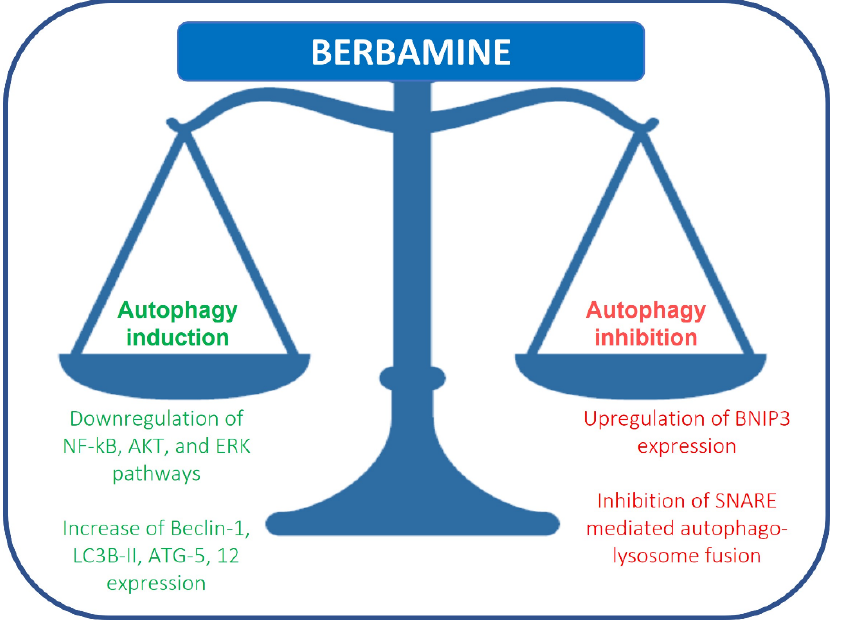
Figure 2. Regulation of autophagy by